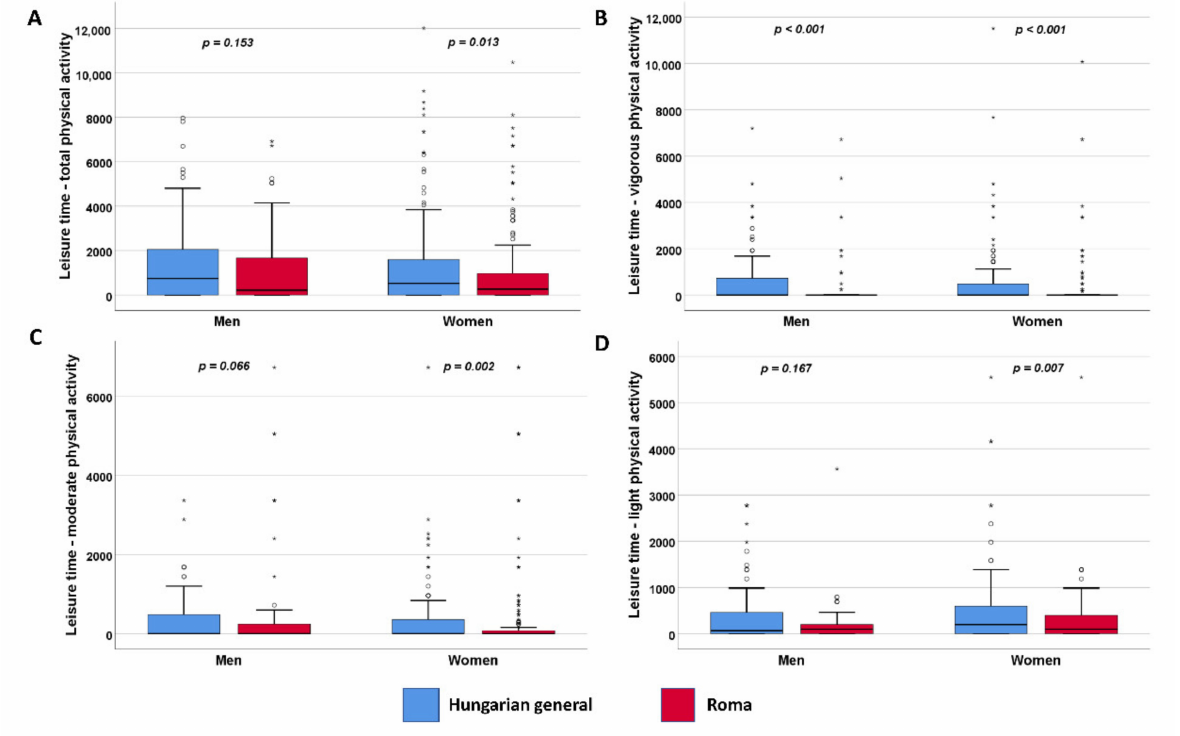
Figure 4. Distribution of leisure time physical activity ( A ) by types and intensity ( B – D ) expressed in MET. ◦ : mild outlier data points; *: extreme outlier data